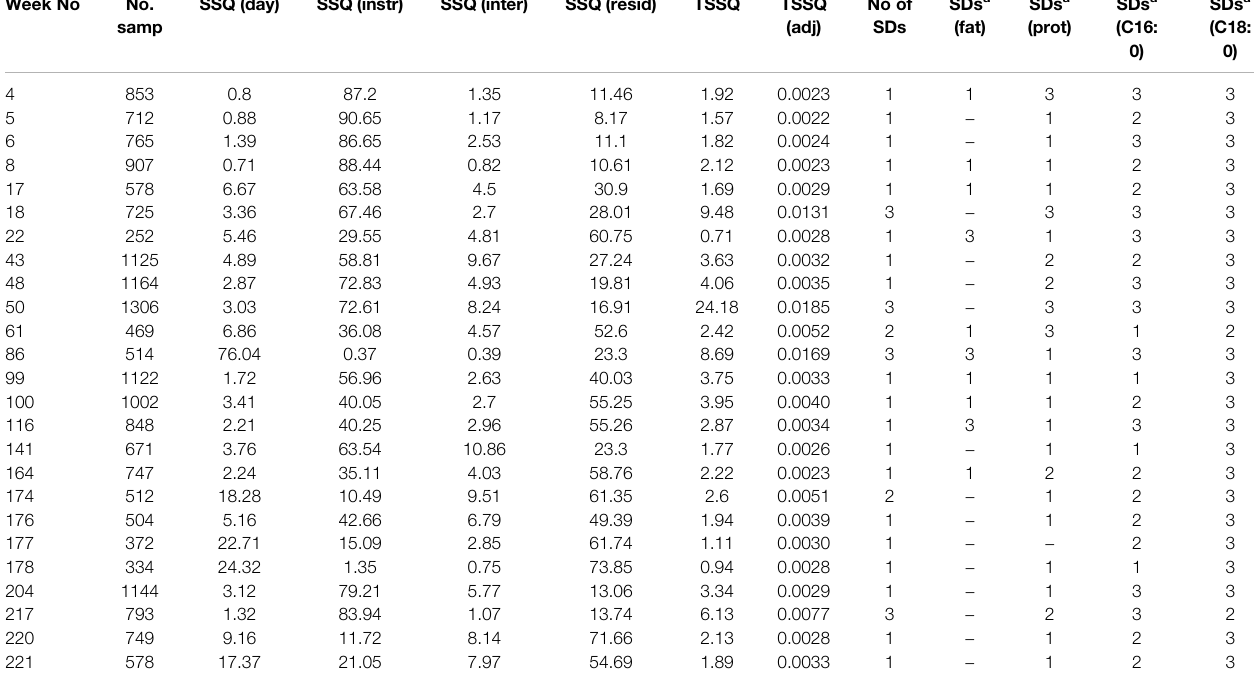
TABLE 1 | List ofweeksinwhichtheTSSQadjustedforsamplenumber[TSSQ(adj)]exceededone,twoorthreetimesthestandarddeviationofthe177 weeks,giveninthecolumn fi fthbeforethelast.Nisthetotalnumberofsamplesineachweek.ThepercentagethateachofthefactorscontributetoeachweeklytotalSSQ[TSSQ(adj)]aregivenasSSQ(day), SSQ (instr) and SSQ (inter) (weekday/instrument interaction). The residual variance due to other factors is SSQ (resid). The number of standard deviations (SDs) by which the SD ’ s in each of MIR predicted values of fat, protein, C16:0 and C18:0 exceed the SD ’ s of the 177 weeks by 1, 2, or 3 SD ’ s are given on the four rightmost columns of the table. Week No No.